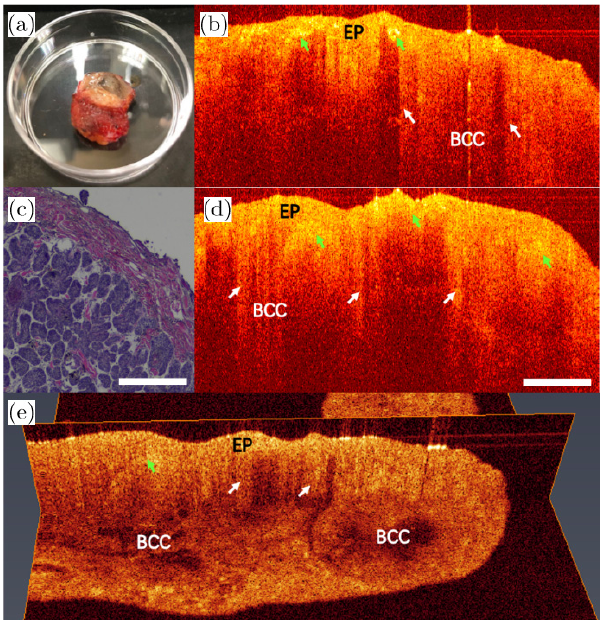
Fig. 4. Images of the BCC. Photo [panel (a)] and 2D OCT images [panels (b) and (d)] of BCC removed from a patient, along with the corresponding histopathological image [panel (c)]. (e) The 3D OCT image. EP: epithelial tissue and BCC: basal cell carcinoma.